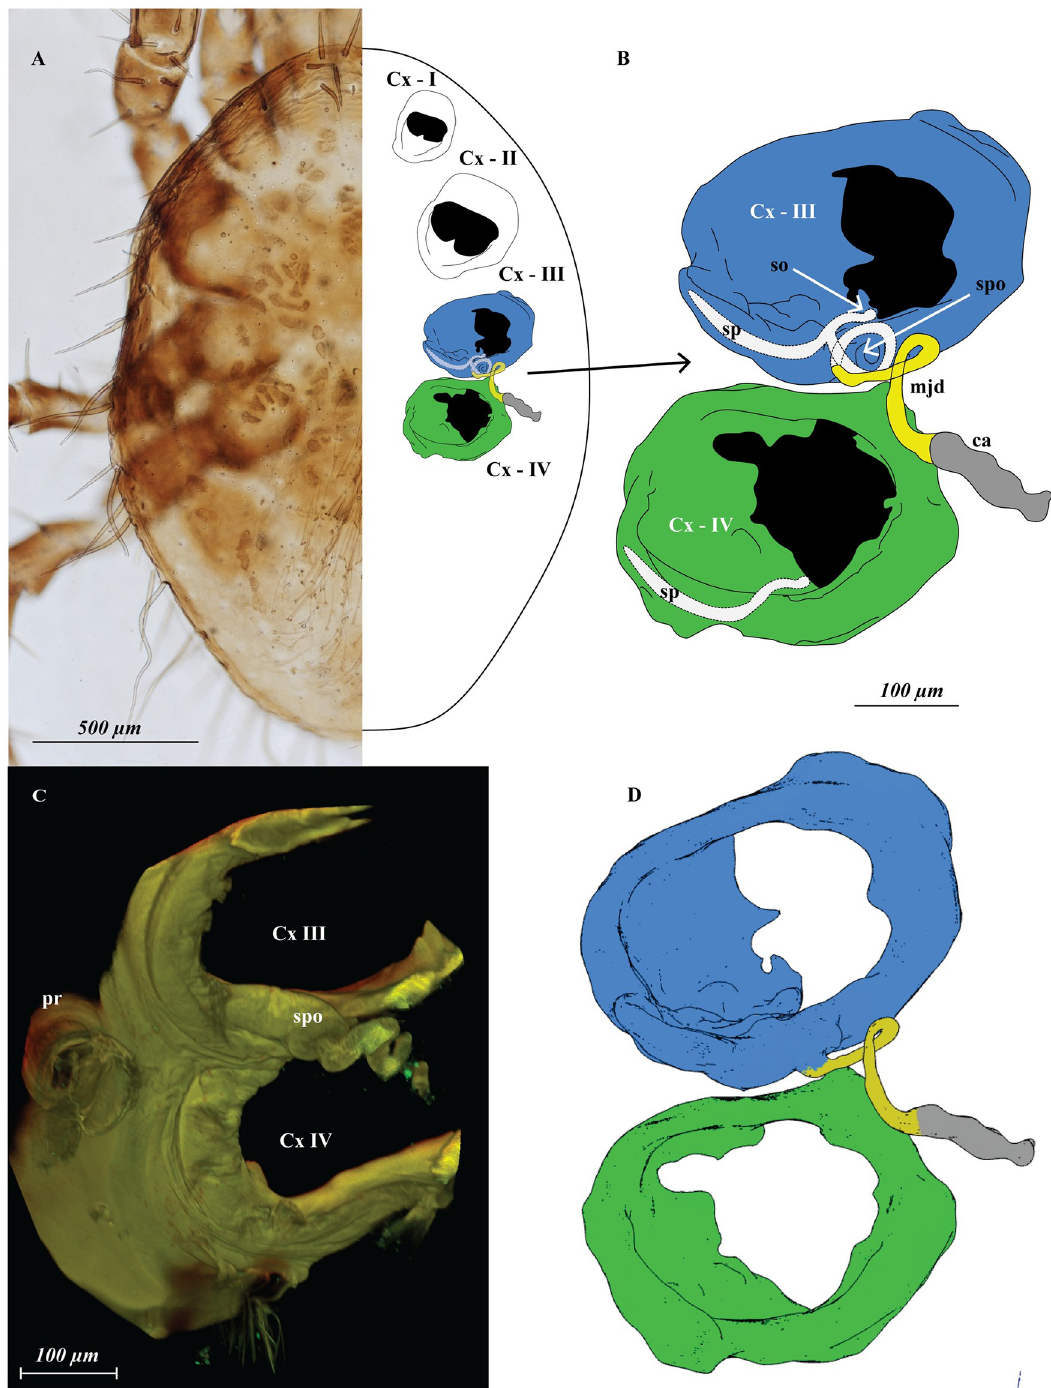
Fig 4. Megalolaelaps females. (A) schematic representation of Megalolaelaps colossus female’s sperm access system (B) detail structure of coxa III and IV. (C) Slide prepared in 1930 with Hoyer’s medium of Megalolaelaps enceladus . Region of coxae III–IV from dorsum to venter, rendered model in FIJI image using CLSM. (D) Screenshot of 3D rotatable model of Megalolaelaps colossus (S1 File) female’s sperm access system with coxa III in blue and coxa IV in green. ca, calyx; Cx I—IV, coxa I—IV; mjd, major duct (yellow); pr, peritreme; so, solenostomes; sp, sperm pocket (dotted); spo, spiral organ.